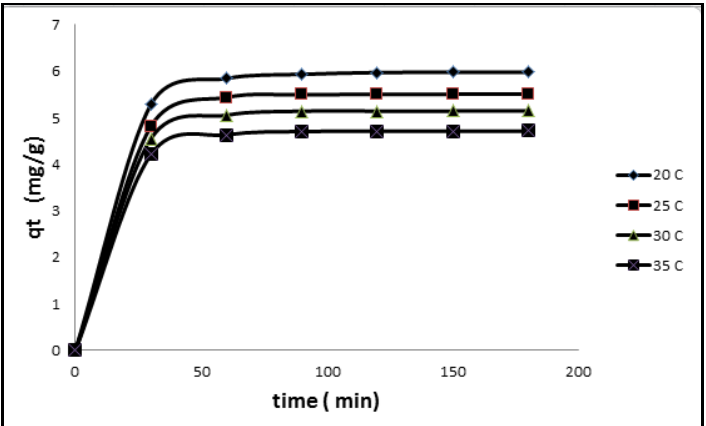
Fig. 8. rate of adsorption for methyLene blue adsorbed on super sand at tmpreture range (20−35) °C.